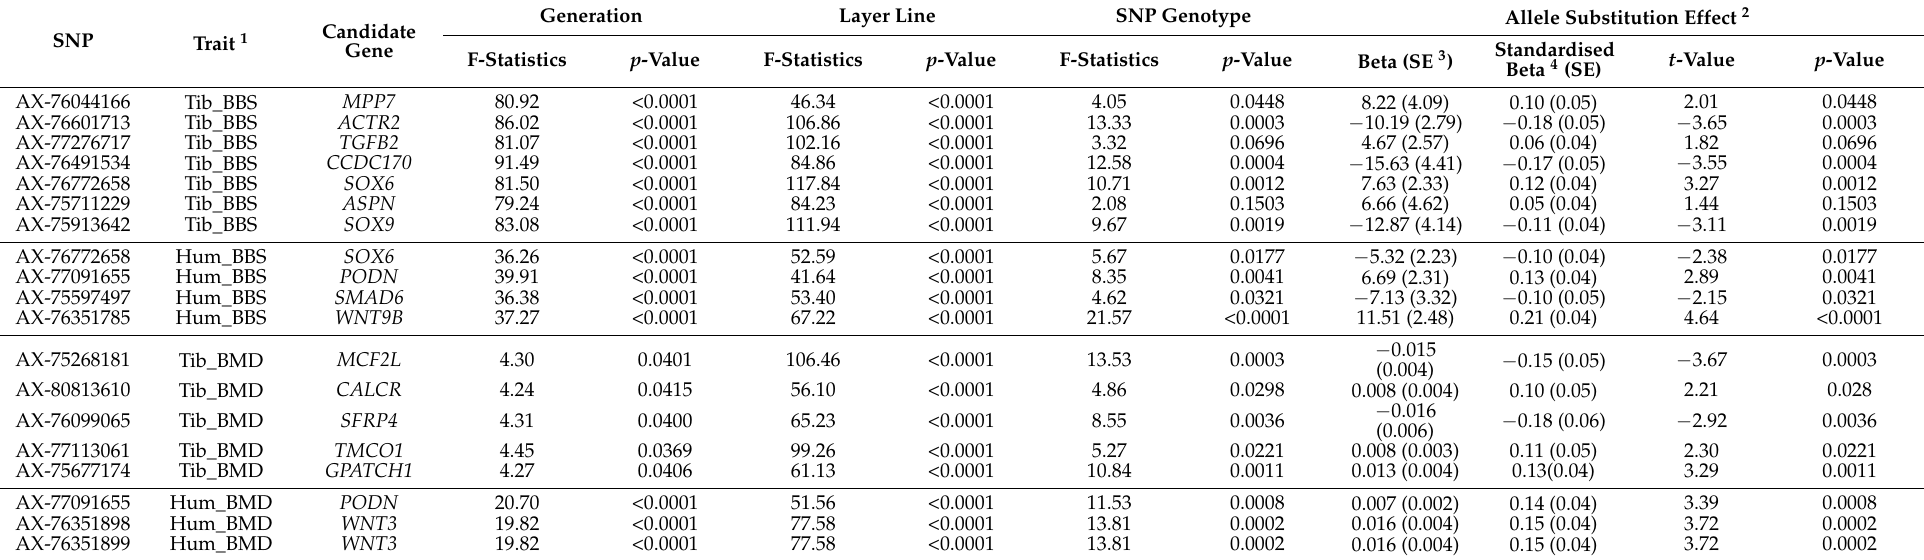
Table 2. SNP effects analysis—Part 1: Analysis of variance table and allele substitution effect obtained from the single marker regression